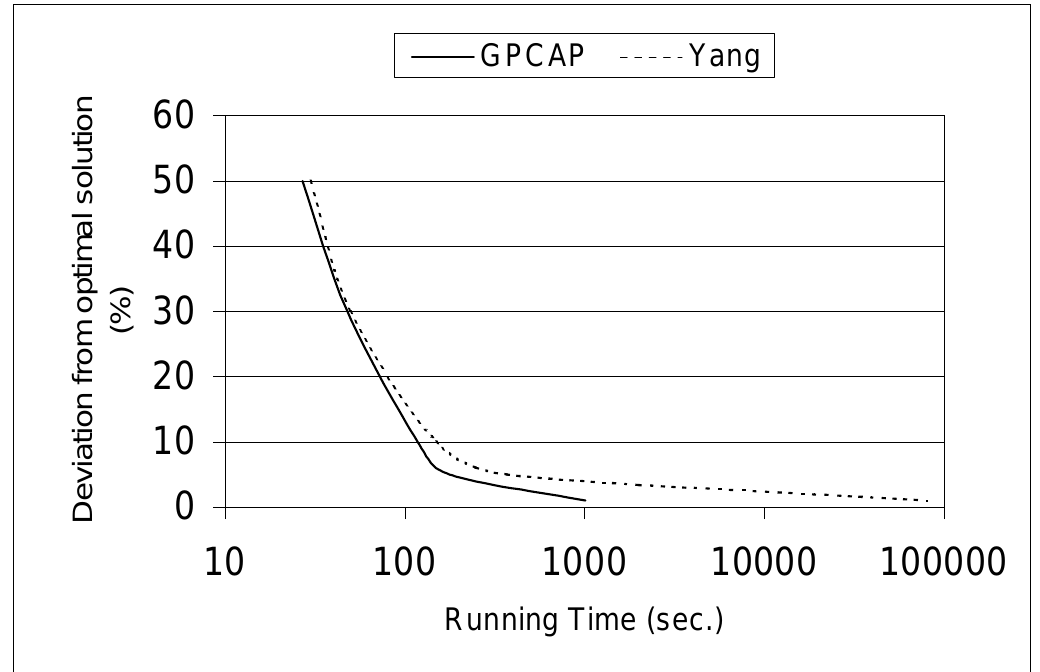
Figure 3. Convergence in Sioux-Falls